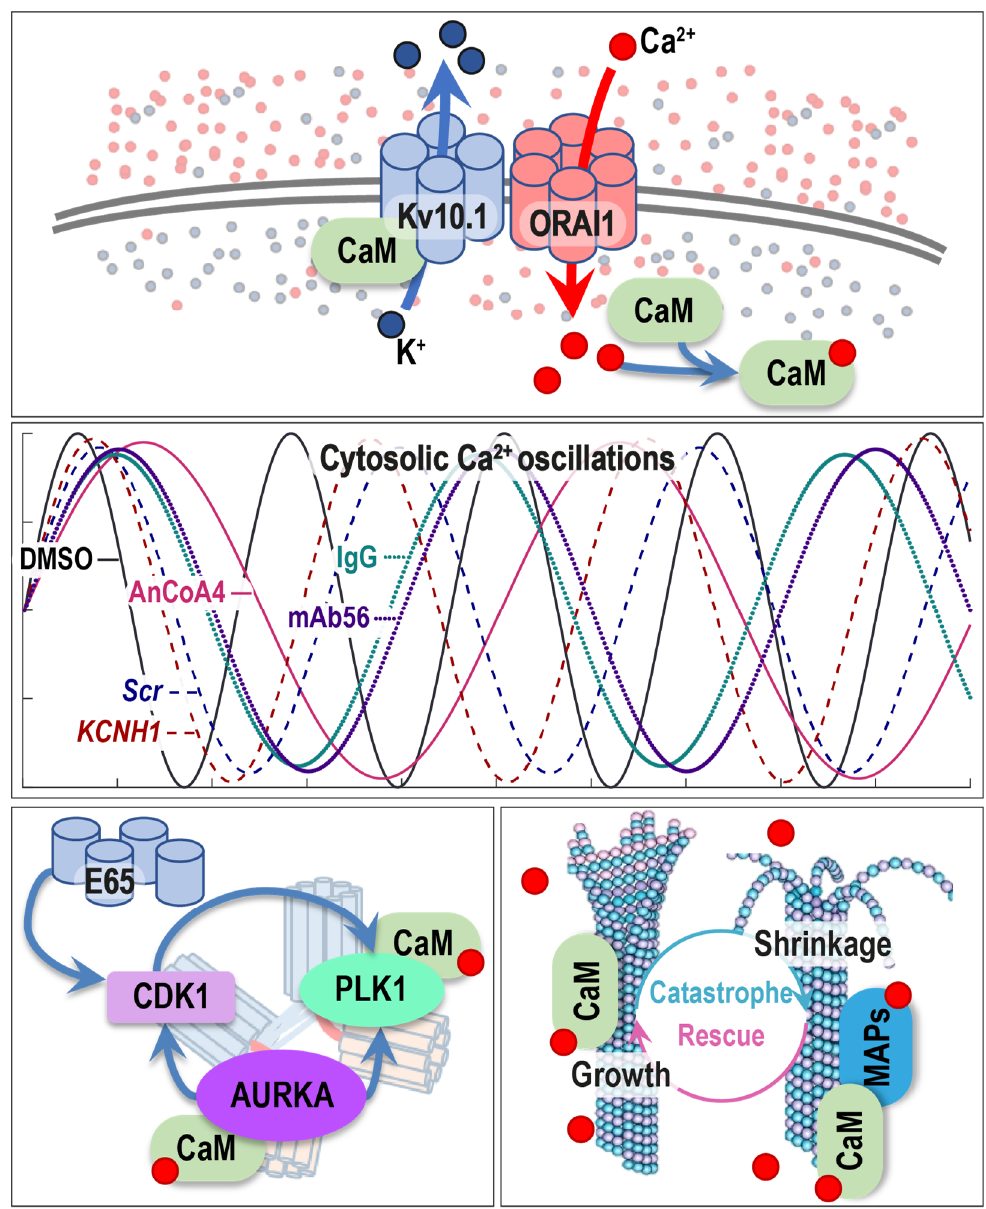
Figure 6. Working model of Kv10.1 action during the G2/M phase. Kv10.1 functionally interacts with ORAI1 creating a self-limiting circuit of Ca 2+ entry (upper panel). Together, these two channels control the oscillations of cytosolic Ca 2+ : inhibition of any of the channels alters calcium entry (middle panel: simulation of calcium oscillations based on the empirically defined frequency values). Some proteins sense such oscillatory changes in cytosolic Ca 2+ . AURKA and PLK1 hold a high potential for such sensory proteins: both kinases are activated upon binding of Ca 2+ /CaM. Additionally, Kv10.1 split variant E65 directly activates CDK1 (low-left panel). As a result of the described changes, the MT assembly rate is modulated. Therefore, Kv10.1, through its canonic ion-channel function and protein-protein interactions, regulates the proper entry and progression through M phase (low-right panel). (K + —potassium ions; Ca 2 + —calcium ions; CaM—calmodulin; E65—split-form of Kv10.1; CDK1—cyclin-dependent kinase 1; PLK1—Polo-like kinase 1; AURKA—Aurora kinase A; MAPs—microtubule-associated